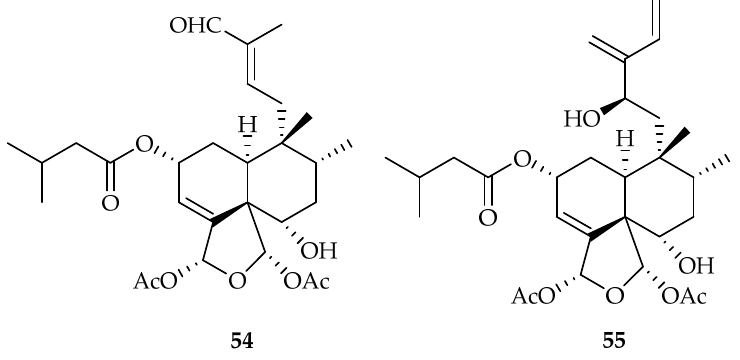
Figure 23. Structures of caseakurzin B 54 [37] and caseakurzin J 55 [37].